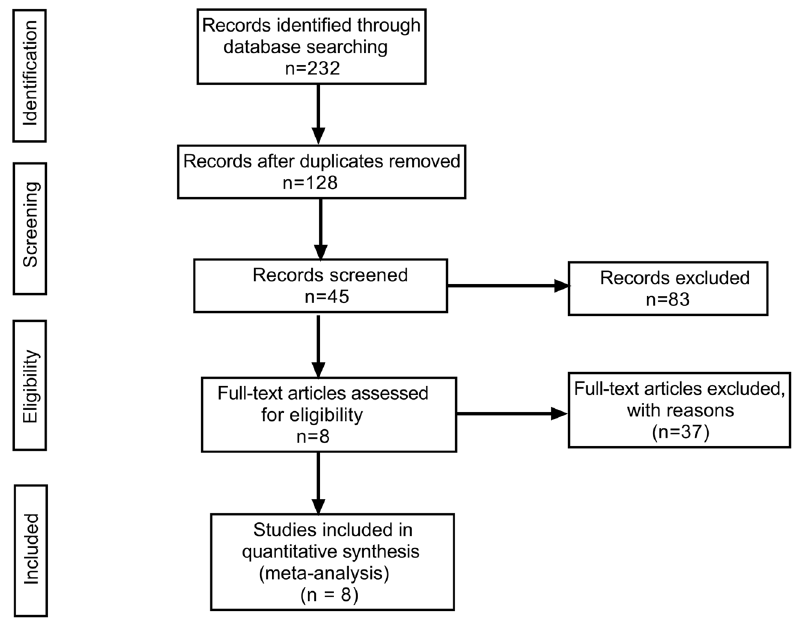
Figure 1: The fl ow chart of study inclusion in the meta -